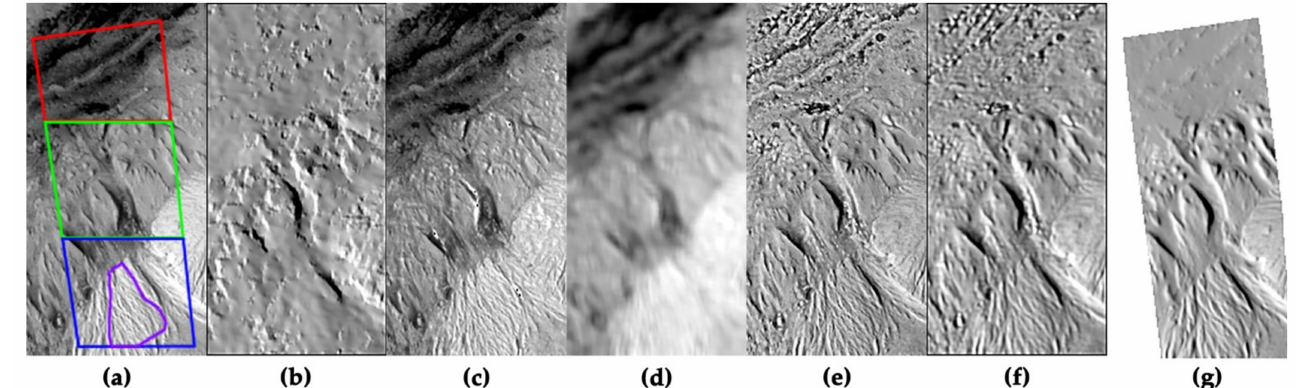
Figure 3. Processing of HRSC data overlapping the HiRISE Traverse 1 (T1) stereopair in Gale crater, Mars to correct albedo variations in HRSC image and refine stereo DTM by photoclinometry. ( a ) Portion of HRSC orthoimage of h4234_0001 nadir image at 50 m GSD, also shown in Figure 1. Quality statistics for areas outlined in color are shown in Figures 9 and 10. ( b ) Synthetic image from USGS HRSC stereo DTM. ( c ) Ratio of orthoimage (after haze subtraction) to synthetic image contains albedo variations and shading due to topography not resolved in stereo DTM. ( d ) Ratio c, smoothed at the DTM resolution of 7 posts, contains albedo variations over larger distances than this. ( e ) Ratio of orthoimage a (haze subtracted) to smooth albedo d contains shading plus albedo variations smaller than 7 pixel resolution. This image was used as input to photoclinometry to refine the stereo DTM. ( f ) Synthetic image from stereo DTM refined by photoclinometry after 16 iterations. ( g ) Synthetic image from HiRISE T1 DTM downsampled to 50 m GSD. Photoclinometry result f appears similar except where image e contained uncorrected albedo variations. All panels are in Equirectangular projection with north at top, latitude of true scale 0 ◦ N, 7 × 13.75 km, centered near − 4.8 ◦ N, 137.8 ◦